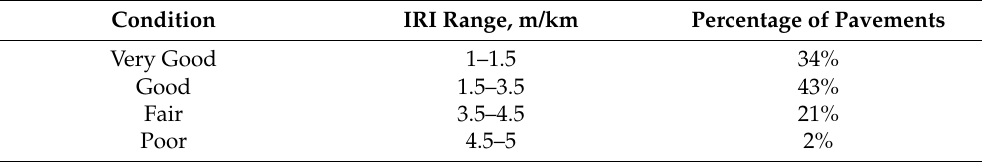
Table 3. Pavement condition according to the IRI.